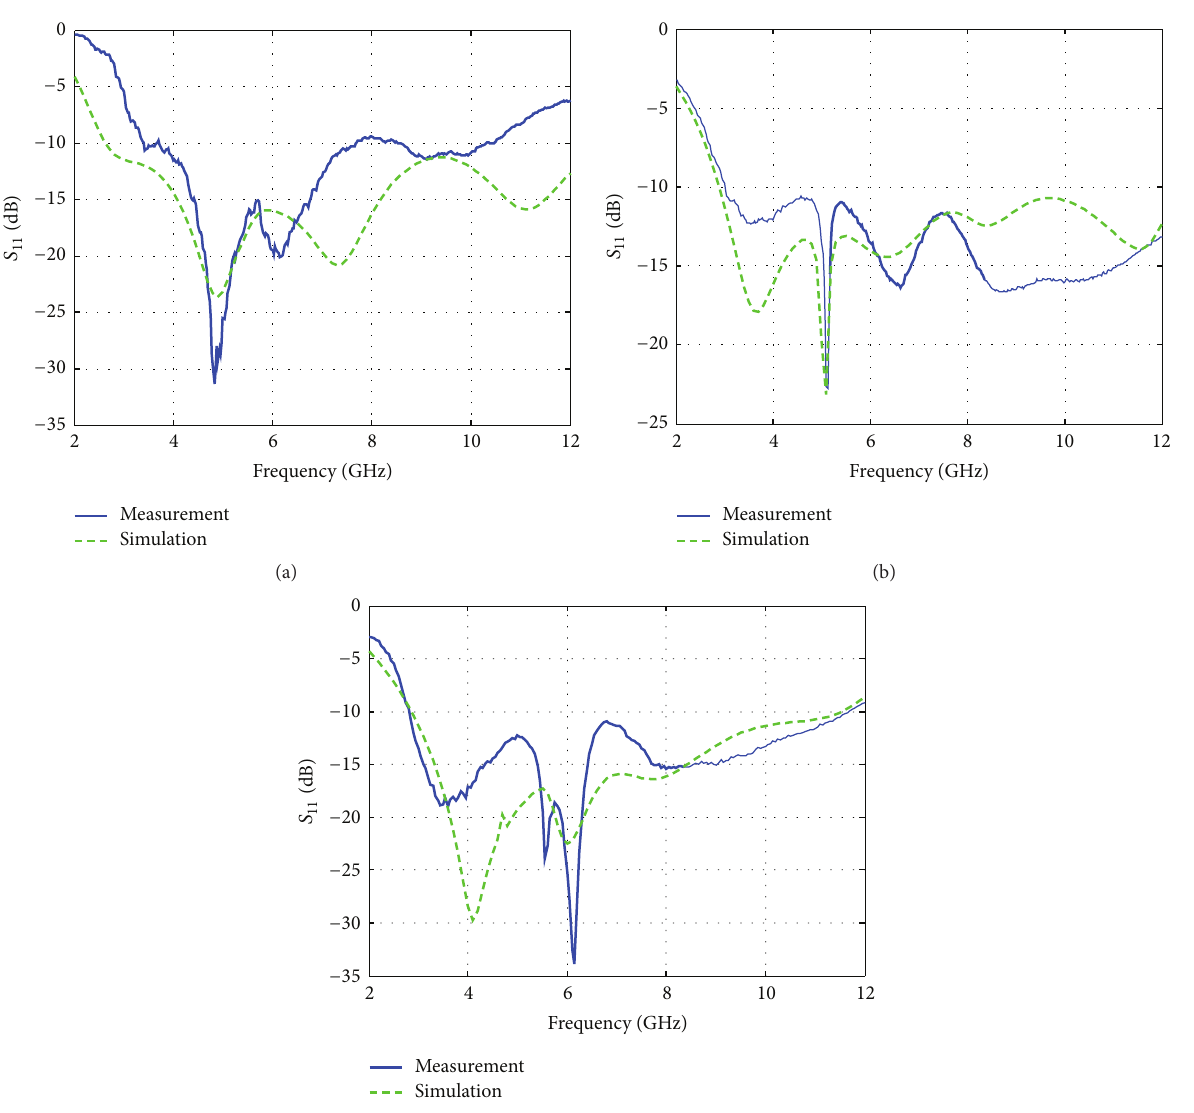
lengths. The middle linear segment is 𝐿2 = 13.00 mm long and 𝑊2 = 2.08 mm wide while the left and right segments are 𝐿1 = 7.28 mm and 𝐿 3 = 1.56 mm long, respectively.